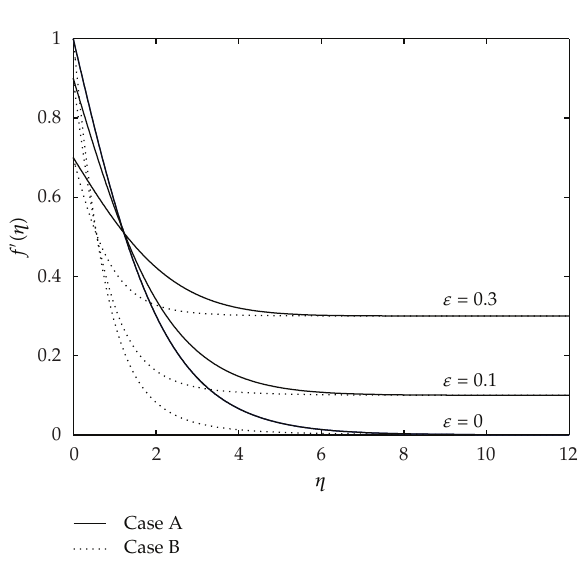
Figure 3: Dimensionless velocity profiles f (cid:4) (cid:5) η (cid:6) for di ff erent values of ε when Pr 0 (cid:8) 1 and a (cid:8) 1. Case A (cid:5) solid line (cid:6) : constant viscosity and Case B (cid:5) dotted line (cid:6) : inversely linear viscosity, (cid:5) 3.5 (cid:6) , and (cid:5) 3.6 (cid:6) .